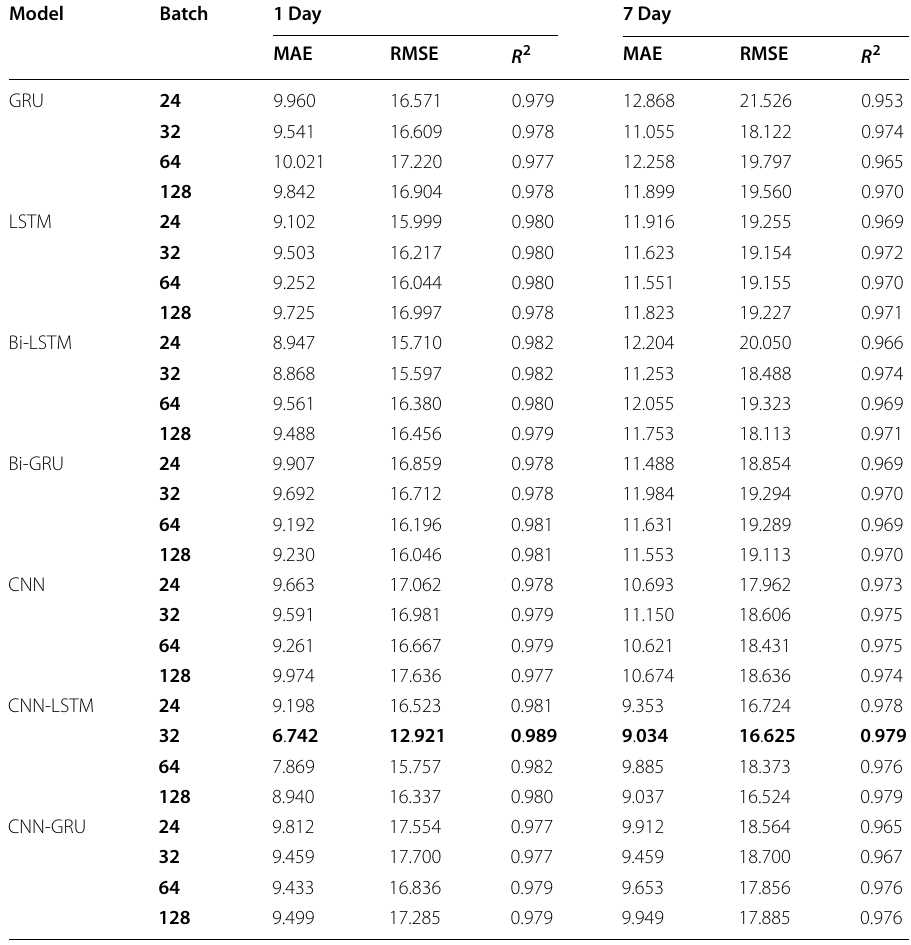
Table 1 Results of different models in 1 and 7-days Lags (Bold indicates the best results.) Model